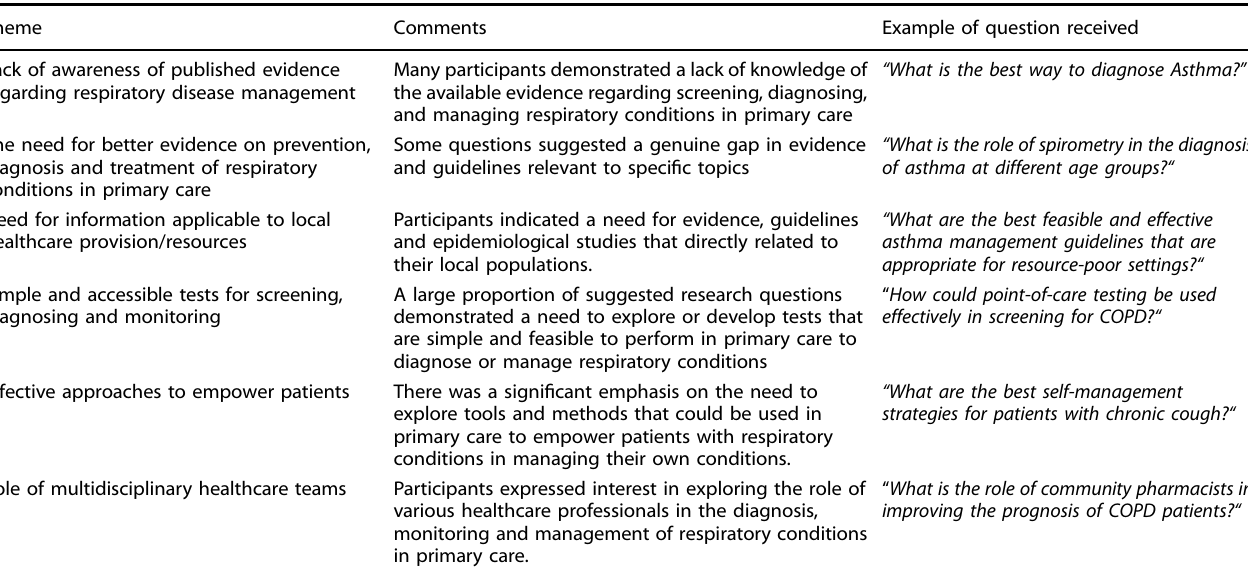
Table 6. Cross-cutting themes from qualitative analysis of open-ended round 1